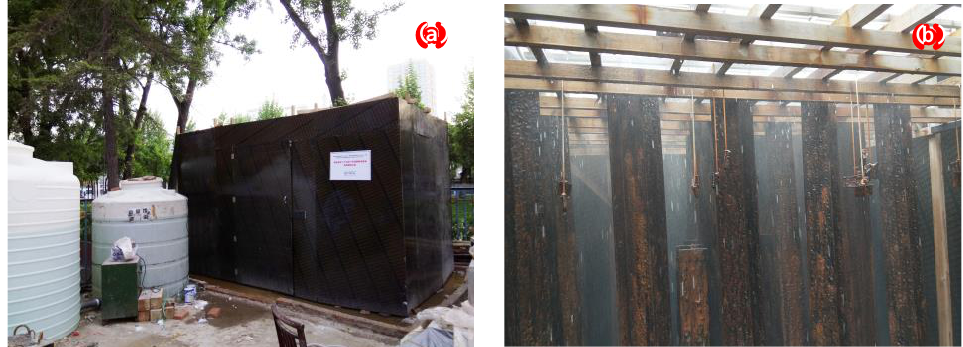
Figure 1. Walk-in natural environment accelerated corrosion test platform: ( a ) general view, ( b ) internal schematic diagram.